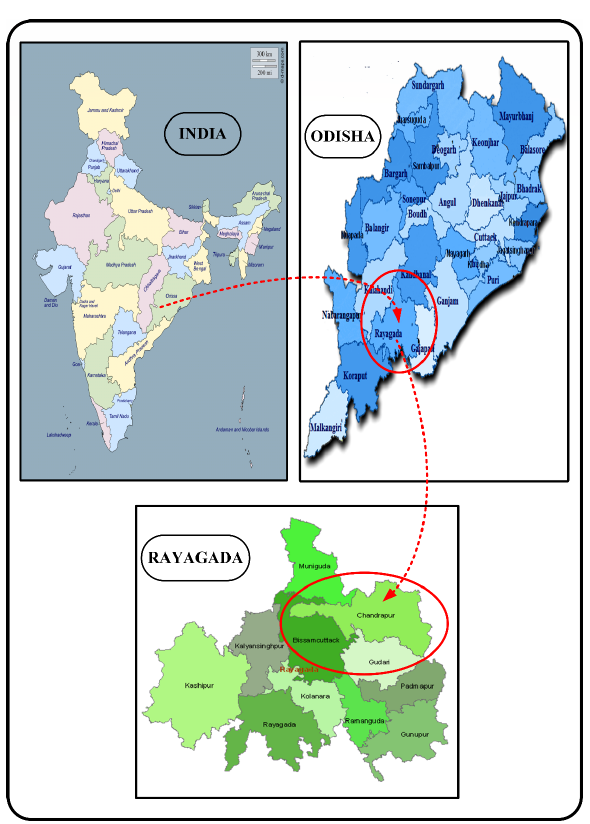
Figure 1. The position of the research region on the Indian map.